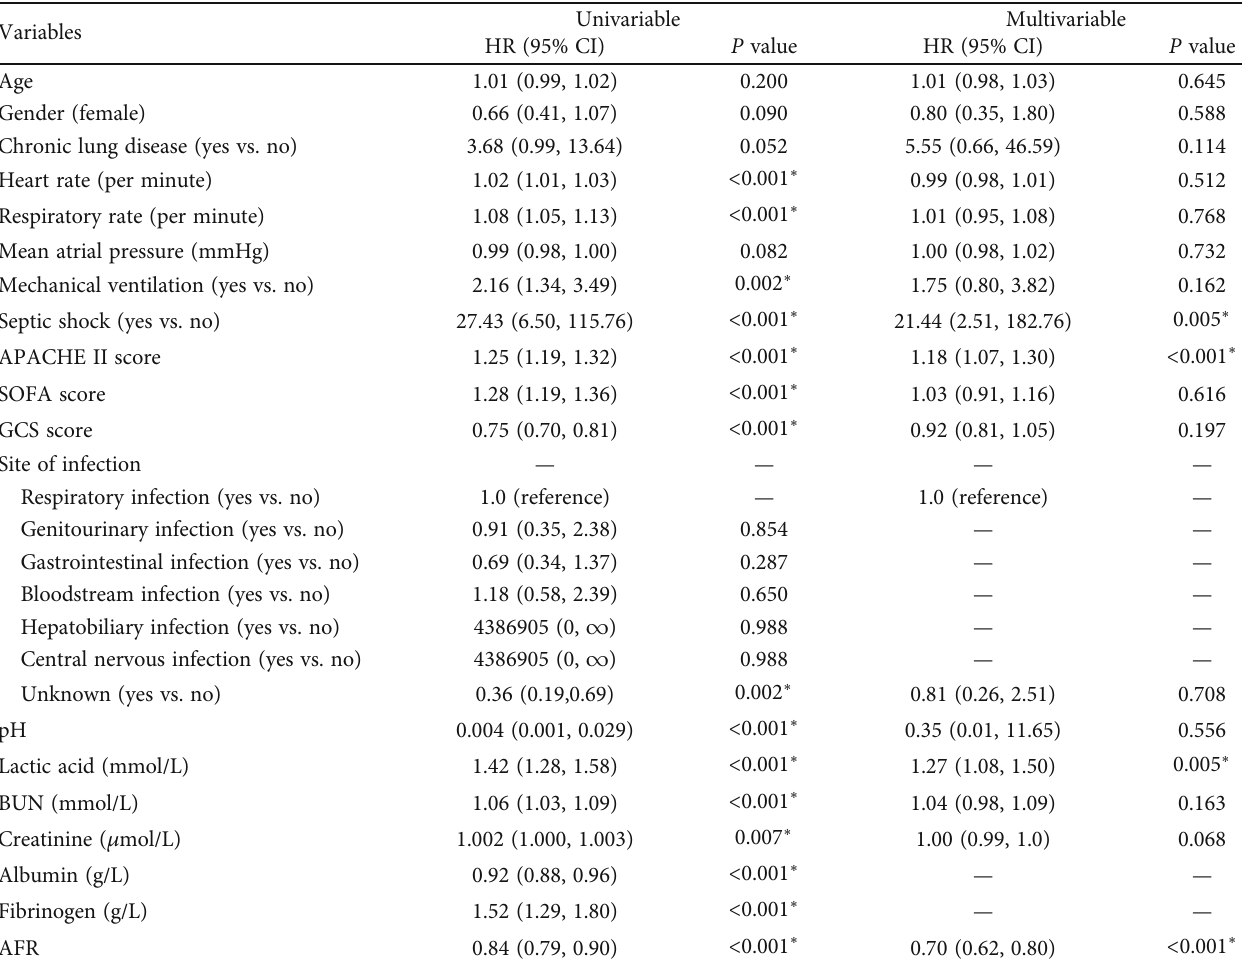
Table 3: Risk factors for 28-day mortality in patients with sepsis by univariate and multivariate Cox proportional hazards regression